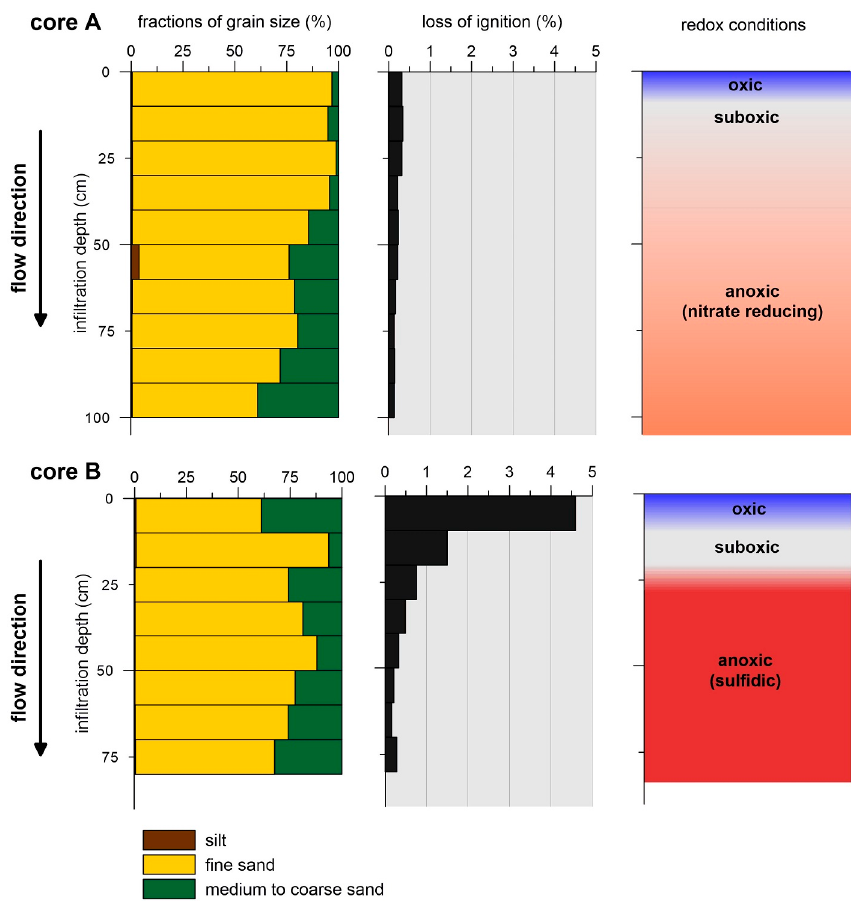
Figure 2. Information on sediment properties (fractions of grain sizes at the left; amount of particulate organic carbon (POC) in the middle) and hydrochemical conditions (at the right) observed along core A (upper part) and core B (lower part). With increasing infiltration depth (from top to bottom) the redox milieu changes from oxic (indicated by blue colours) to suboxic (indicated by grey colors) to anoxic (orange = manganese reducing; red = sulfidic).